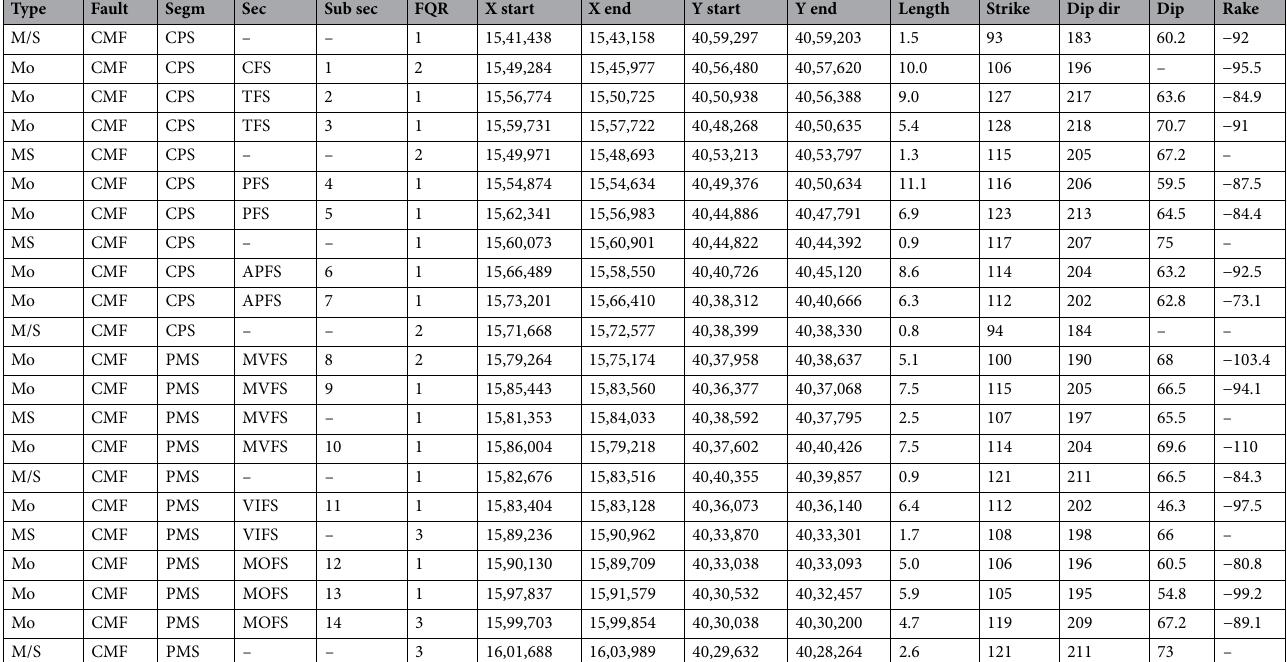
Table 2. Summary table of segmentation. Coordinates and measurements refer to the Sub-section. Type: Mo = Main outcropping; M/S = minor/splay. Segm. = segment. Sec. = section. Sections’ acronyms as in Table 1. Sub sec. = subsection, numbered as in Fig. 6. FQR = Fault quality ranking. X-start, X-end, Y-start, Y-end coordinates of the Sub-section. Dip dir. = dip direction. Rake is in Aki-Richards’